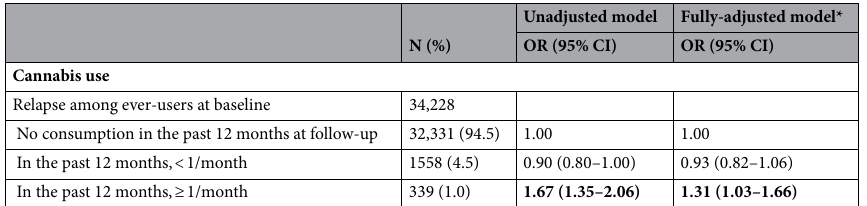
Table 3. Association between high physical exertion at work and cannabis use at 1-year of follow-up among employees in the CONSTANCES cohort study, 2012–2018 (odds ratios (ORs), and 95% confidence intervals, CI). Significance values are given in bold. *Adjusted for age (years, continuous), sex, occupational grade (low; medium; high), depressive symptoms at baseline (no; yes), educational level (levels, continuous) and household income (€/month, continuous).